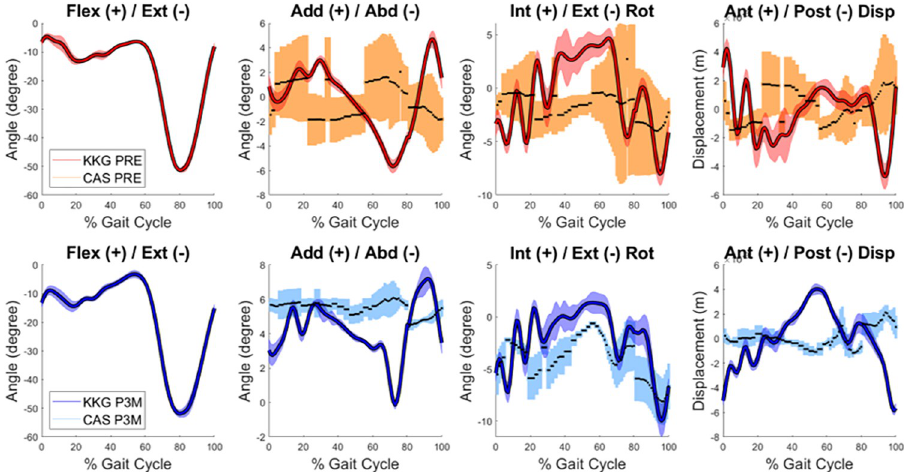
Fig 3. Comparison of the degrees of freedom measured during computer-assisted navigation and treadmill gait assessement for patient 1, before (PRE) and after (P3M) surgery.